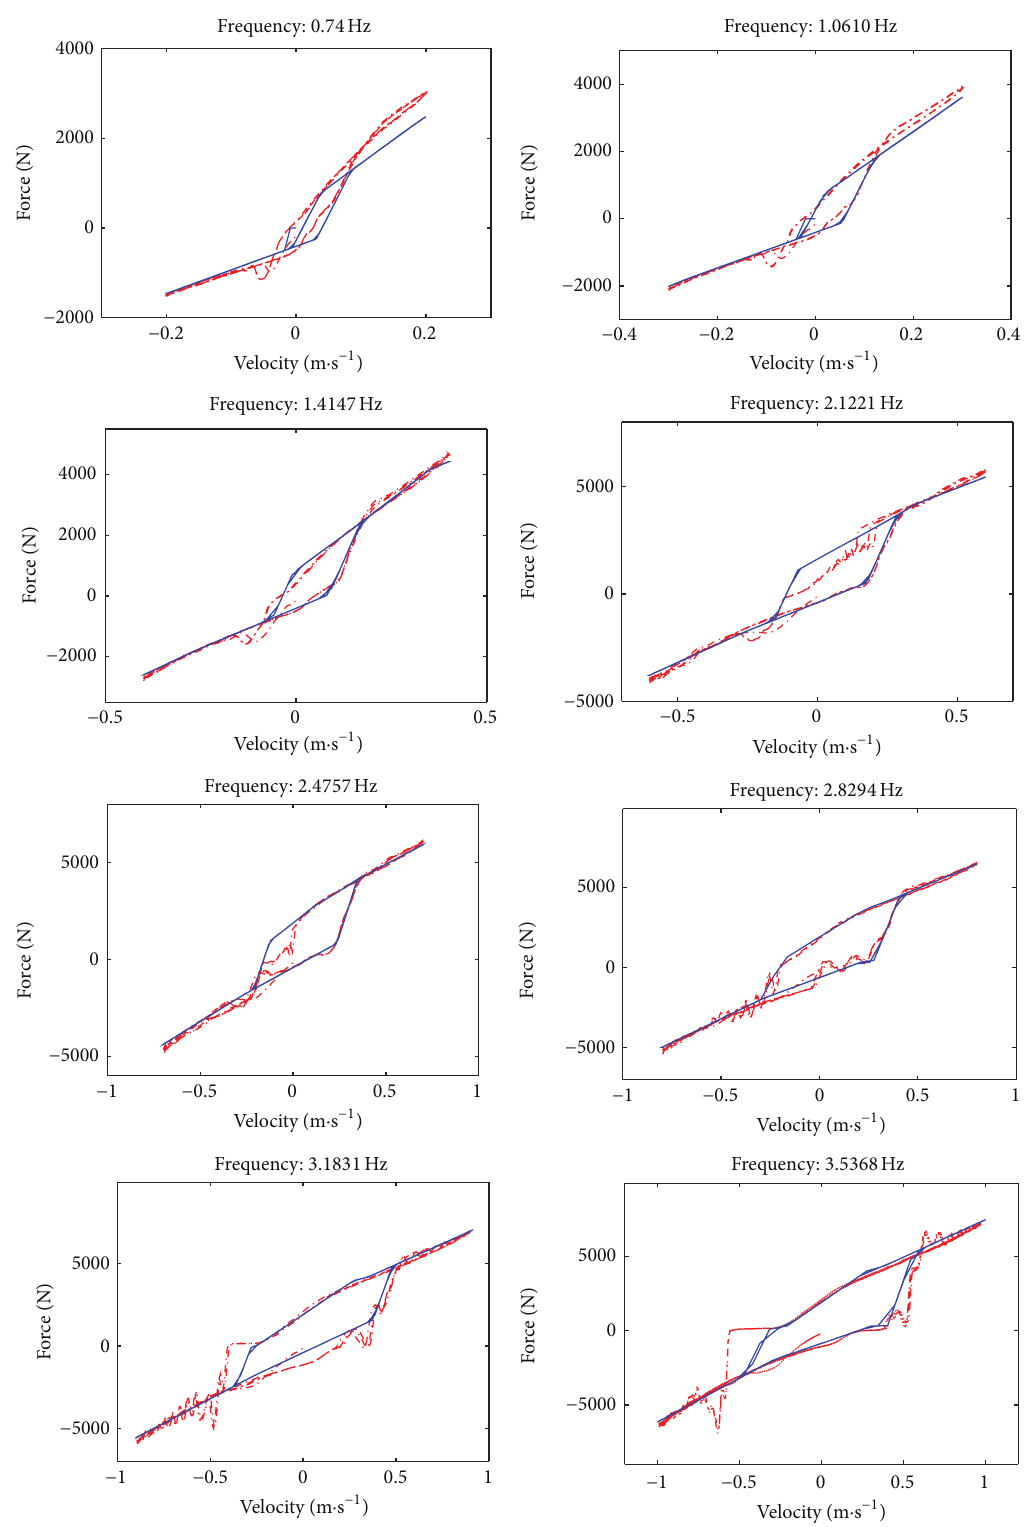
Figure 9: Comparisons while the amplitude of displacement is 45